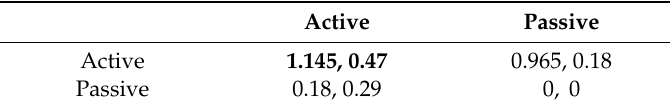
Table 11. Payo ff matrix A for 2 × 2 (Scrum Master vs. OTM) game for the partial e ff ective team with